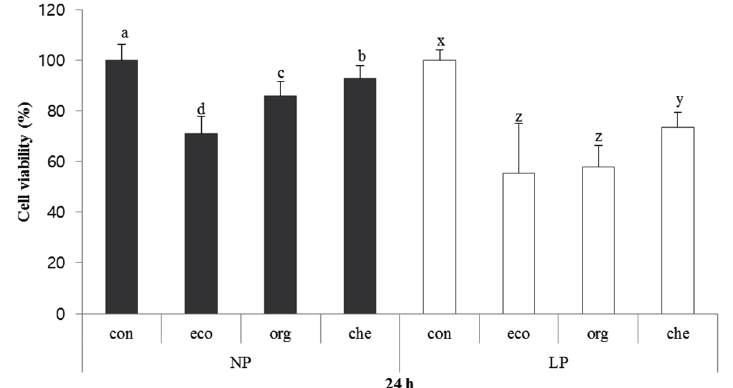
Figure 3. Viability of HepG2 cells cultured with different chicory extracts for 24 h. All values are expressed as means ± standard deviation. Values with different letters denote statistical difference ( p < 0.05). Letters a–d are used to denote comparisons within NP groups;